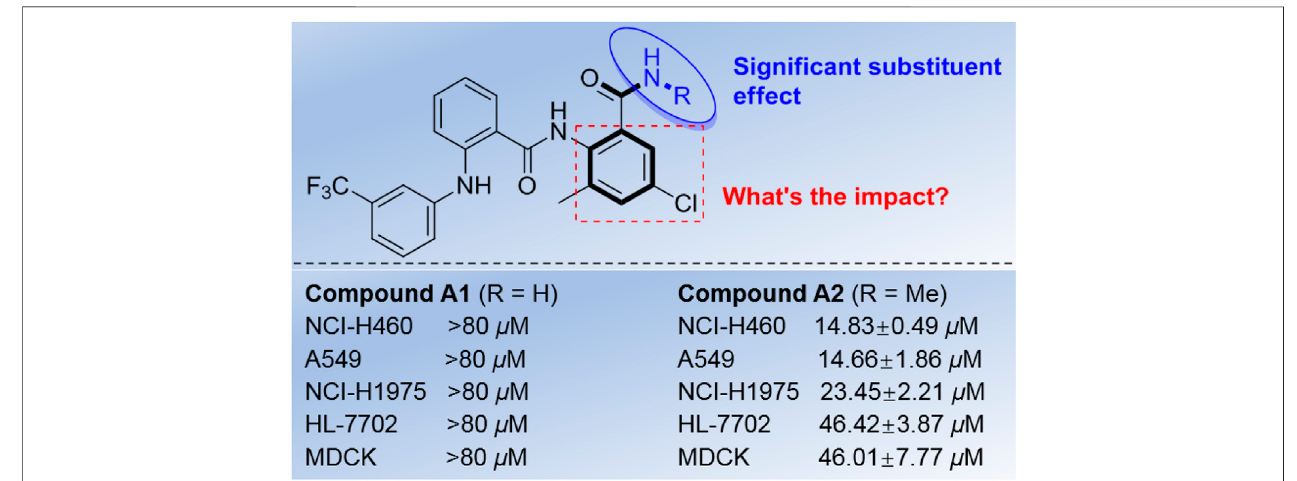
FIGURE 2 | Diarylamine-guided diamide derivatives as lead molecules.